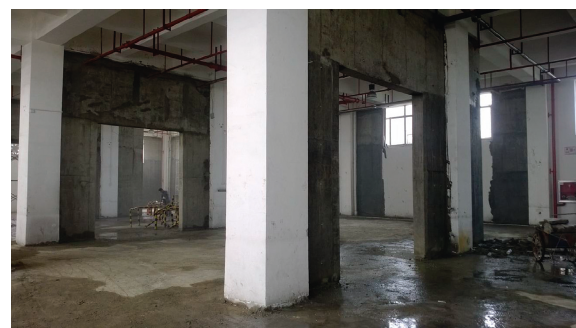
Figure 10: View of short-pier shear walls.